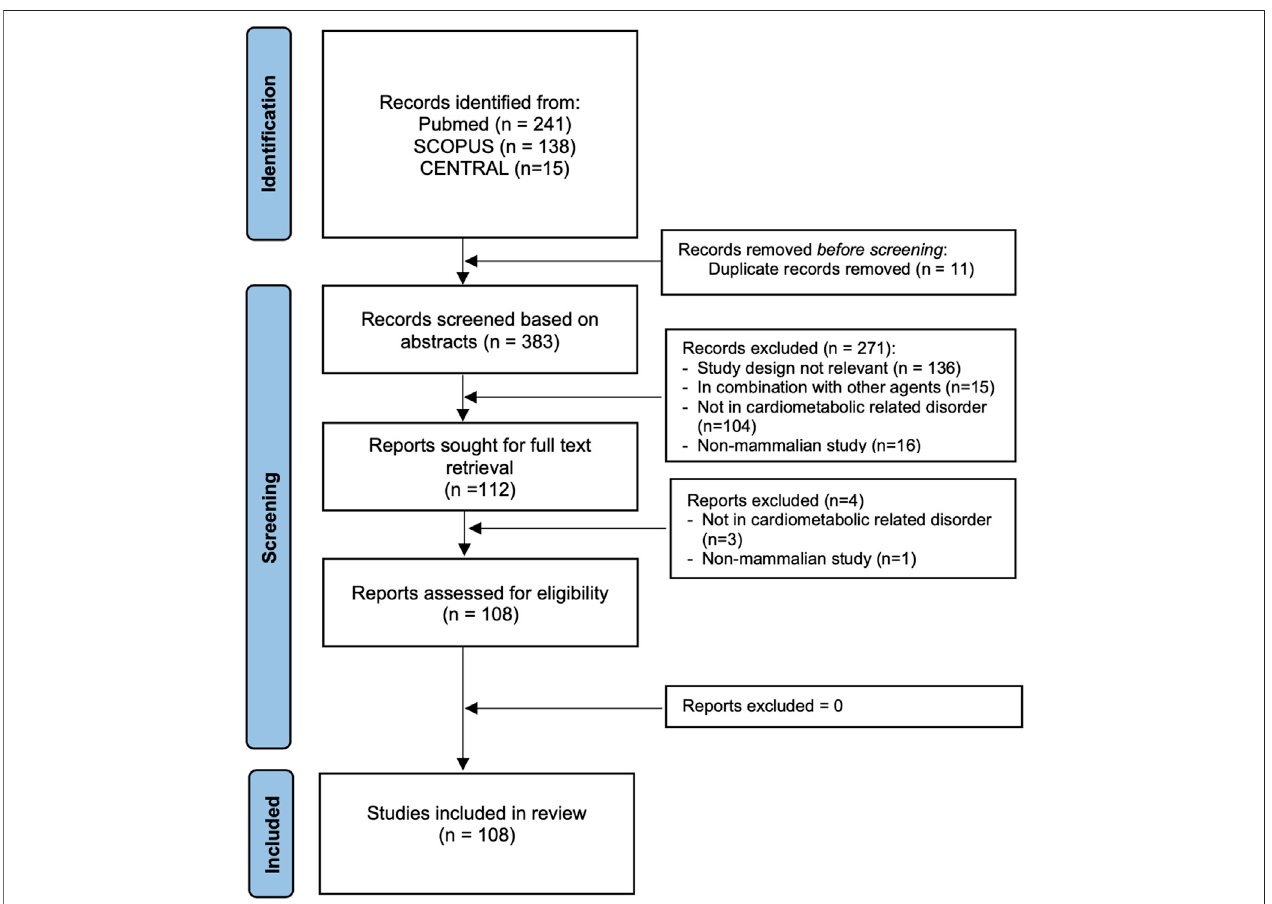
FIGURE 1 | Flow of article selection in the